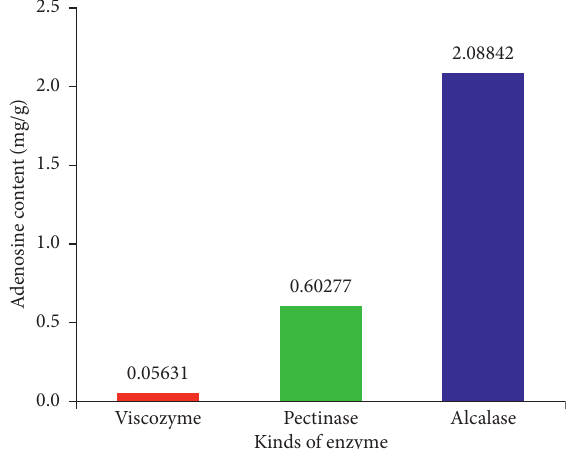
Figure 2: Effect of different kinds of enzymes on adenosine